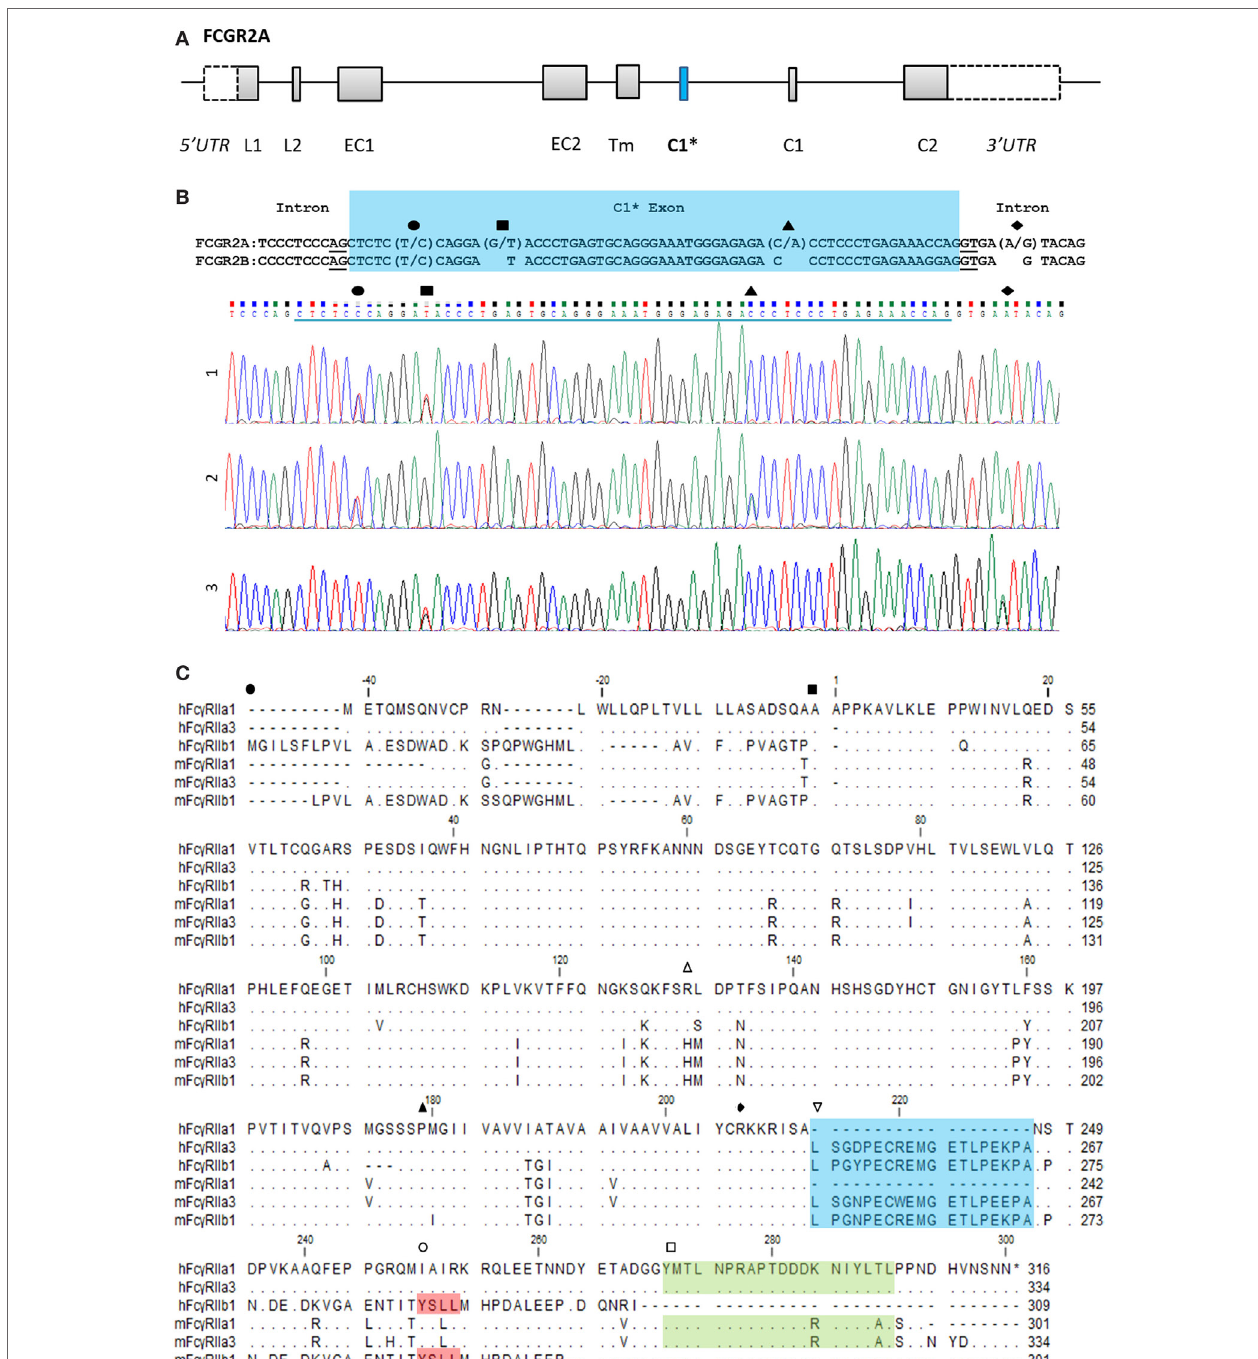
FigUre 1 | FCGR2A organization and the C1* exon. (a) Organization of the FCGR2A gene. Exonic regions are represented as boxes and intronic regions as a line. Leader, (EC) extracellular, (Tm) transmembrane, and (C) cytoplasmic tail. (B) Alignment of genomic DNA sequence surrounding the C1* exon of FCGR2A and FCGR2B with single nucleotide polymorphisms and exemplar electropherograms of Fc γ RIIa3 from three individuals. SNPs are indicated thus: exonic ( ● ) C/T, ( ■ ) G/T, and ( ▲ ) C/A SNPs which result in proline to serine, aspartic acid to tyrosine, or threonine to asparagine substitution, respectively. The intronic A/G SNP, ( ◆ ), in electropherogram 3, reported to promote splicing of C1* exonic sequences results in a unique 19-amino acid insertion in the Fc γ RIIa3 cytoplasmic tail. (c) Amino acid alignment of human (h) and macaque (m) Fc γ RIIa1, Fc γ RIIa3, and Fc γ RIIb1 (32). cDNA sequences were derived from healthy human or macaque PBMC samples. Dot ( ∙ ) represents residues matched to human Fc γ RIIa1 sequence; dash (-) represents a gap in sequence alignment. The N-terminal end of different Fc γ R structural domains are indicated: ( ● ) leader sequence, ( ■ ) extracellular domain, ( ▲ ) transmembrane region, and ( ◆ ) cytoplasmic tail. Regions of interest are denoted with ( △ ) polymorphic 131 residue, ( ▽ ) C1 exon (blue), ( ⚪ ) ITIM in Fc γ RIIb sequence (red), and ( □ ) immunoreceptor tyrosine activation motif Fc γ RIIa (green) regions highlighted.